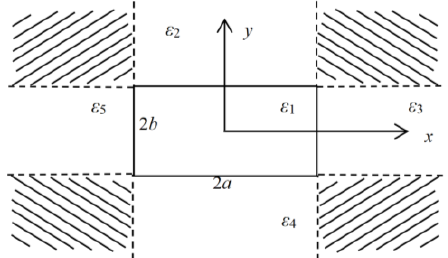
Figure 6. Region division for theoretical analysis.